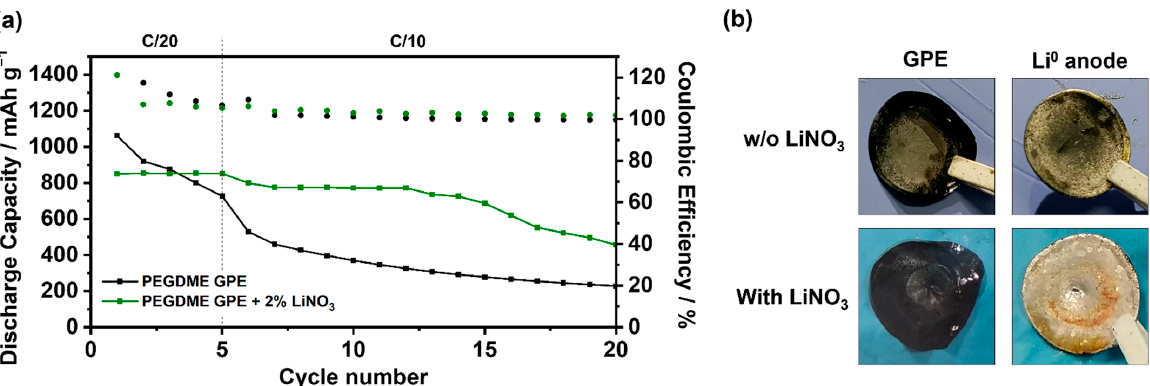
Figure 5. ( a ) Comparison of the battery performance of PEGDME_GPE with and without LiNO 3 additive and ( b ) their corresponding optical post-mortem analysis of the membranes and Li 0 anodes.